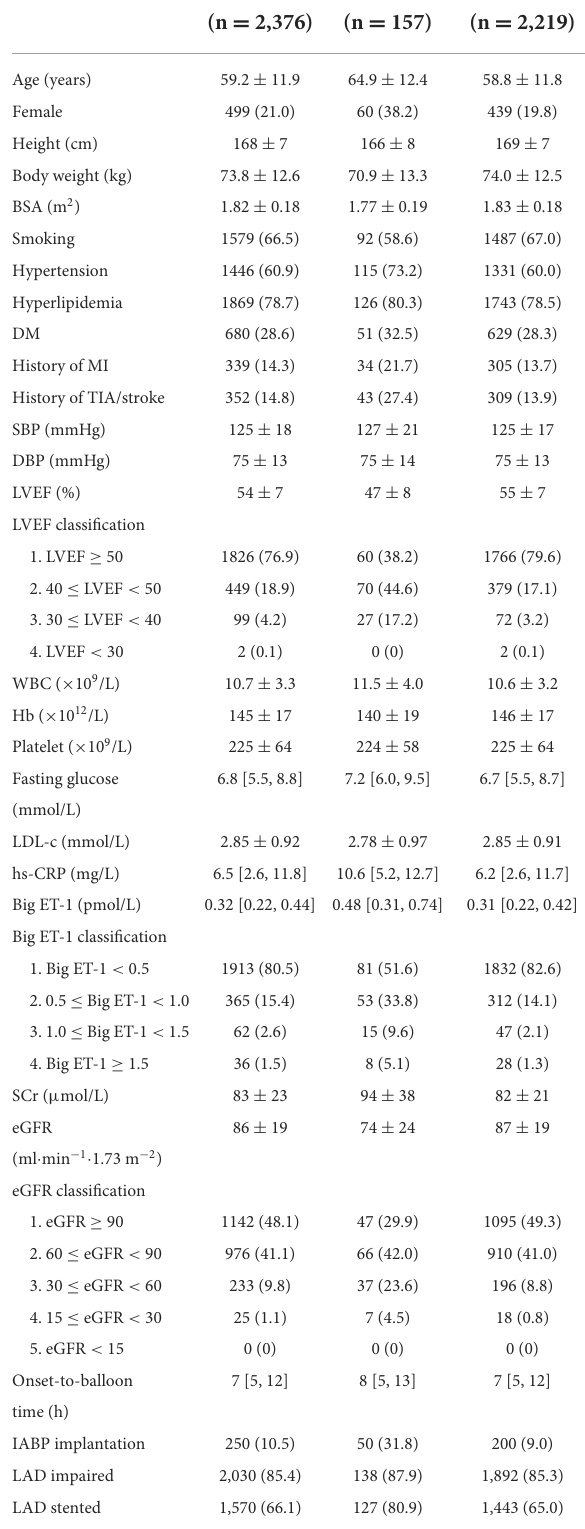
TABLE 1 Clinical characteristics in the derivation